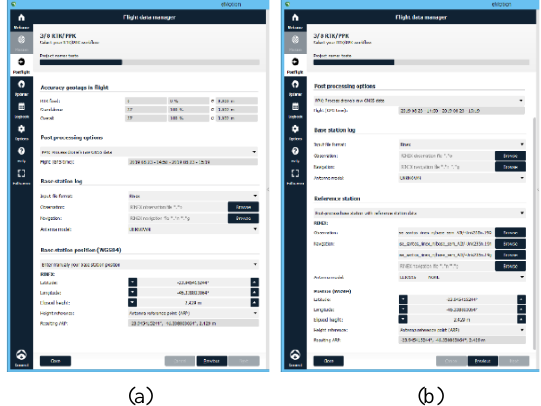
Figure 4 – DG post-processing considering the base